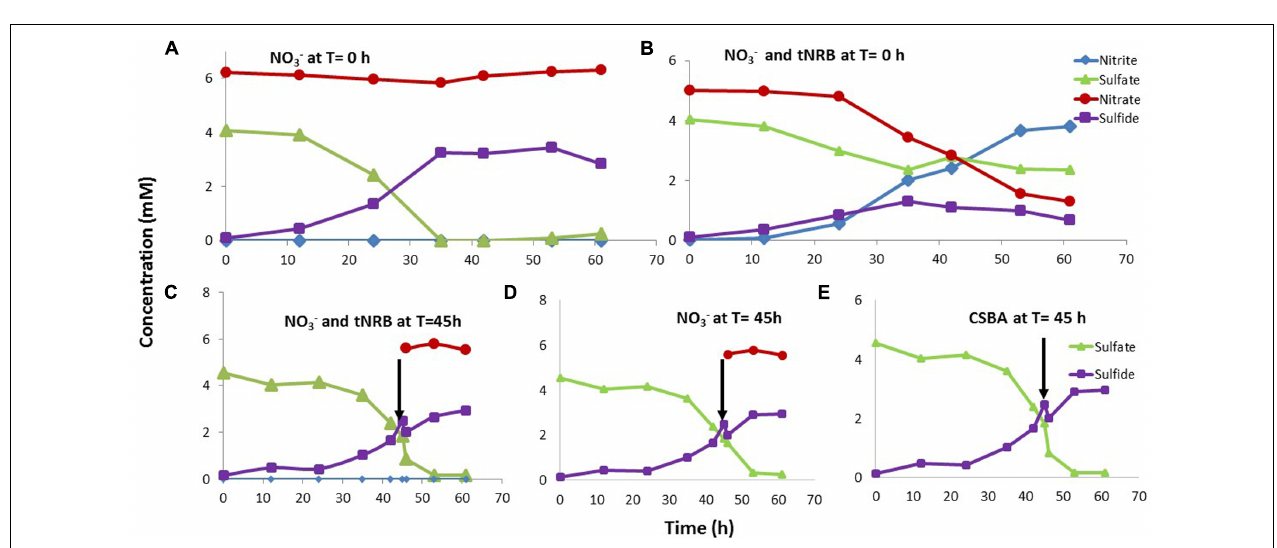
FIGURE 7 | Effect of addition of nitrate or of nitrate and tNRB on sulfate reduction by tSRB consortia grown at 60 ◦ C. Nitrate (A) or nitrate and tNRB (B) were added at T = 0 h (A,B) or at midlog phase of sulfate reduction at T = 45 h (C,D) ; 100 µ l of CSBA medium was added as a control at T = 45 h (E) . Data are averages for duplicate